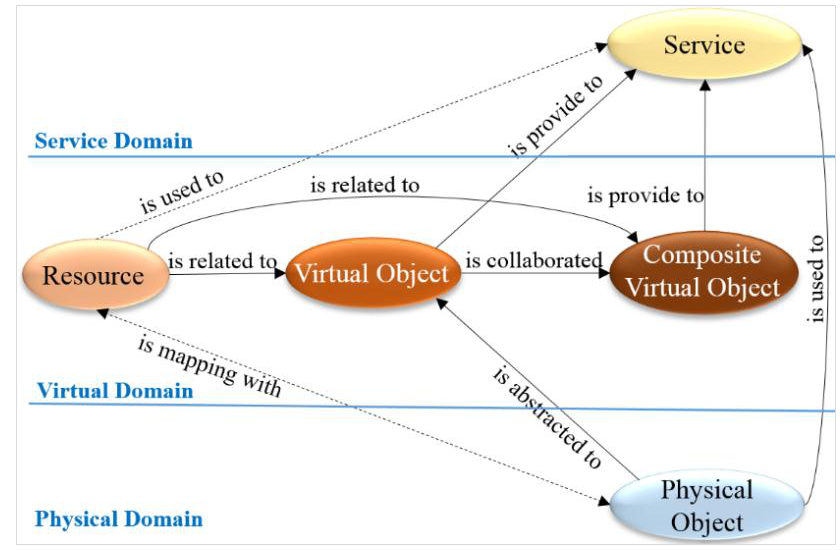
Figure 3 . The object relationship model in the WoO platform relates physical objects and resources to provide services